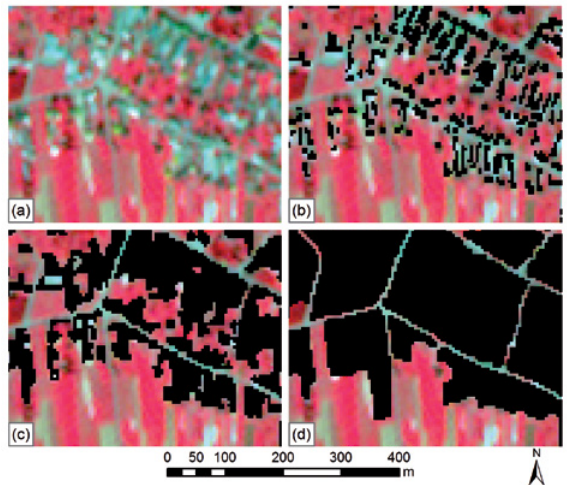
Fig. 3. classification of “Sparse built-up areas” using BBRE (a) and GIS-vector data performed in three steps: classification based on vector data (b), classi- fication of objects on higher scale level (c), and final generalization using the highest scale of objects